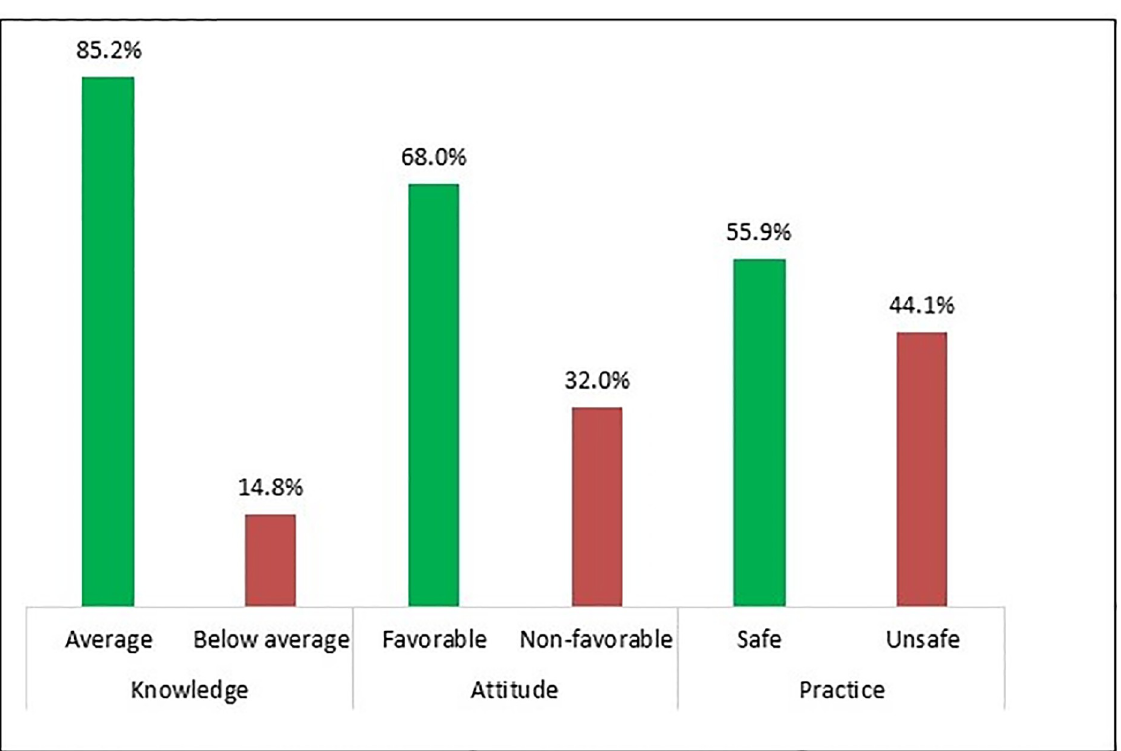
Fig 3. Percentage of distribution of two main categories of KAP of nurses towards IPC at DMCH in Bangladesh.